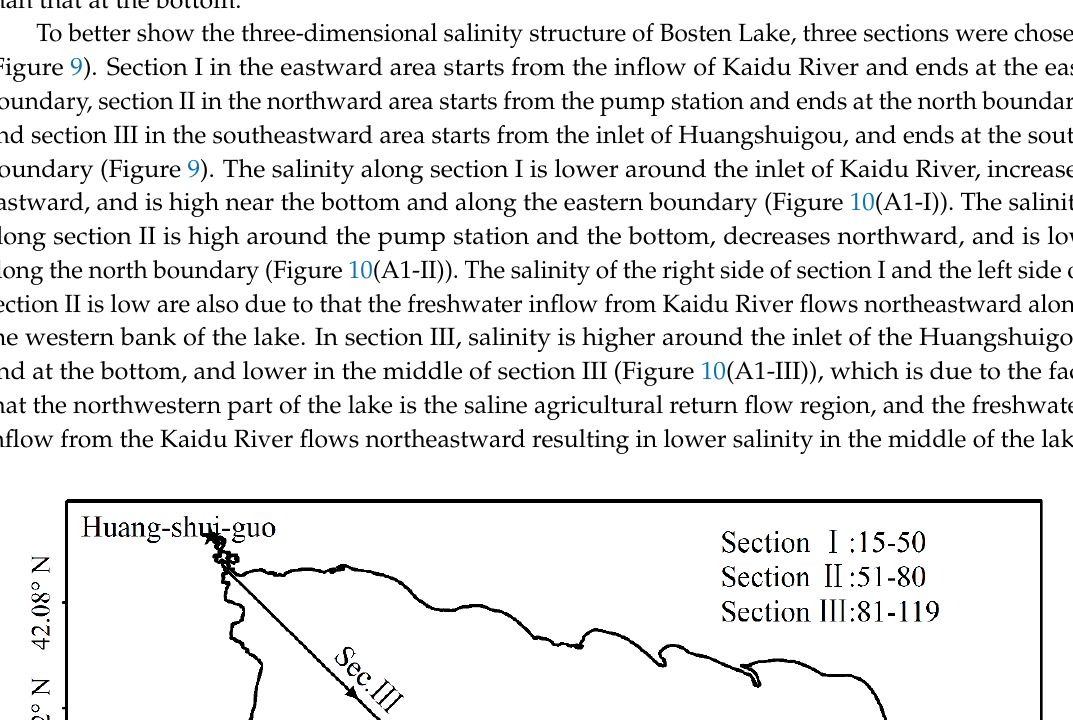
Figure 10. Distribution of modeled salinity at ( A1-I ) Section I, ( A1-II ) Section II, and ( A1-III ) Section III in experiment A1. 3.3. Effects of River Discharges on Salinity Distributions To study the impact of Kaidu River discharge on the salinity distribution, experiments A2–A5 were set. Experiments A2 and A3 are similar to experiment A1, except the Kaidu River discharge at